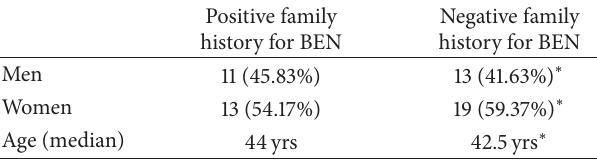
Table 1: Demographic structure of the examined